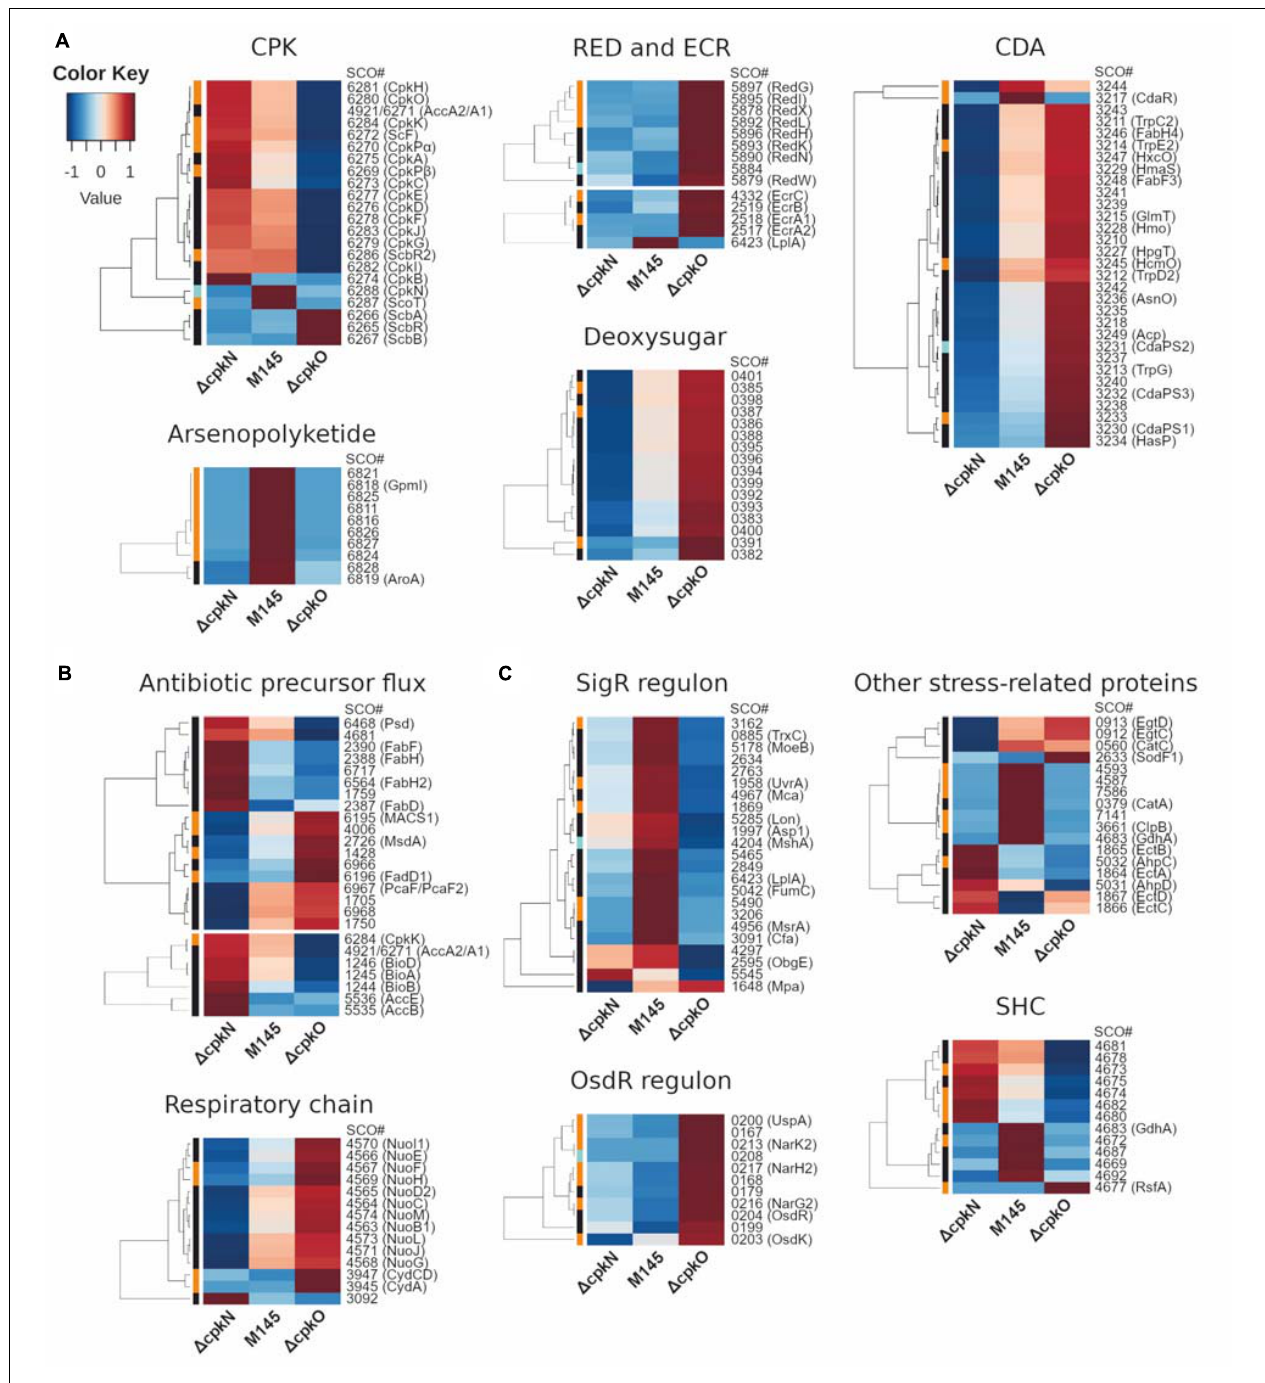
FIGURE 3 | Heatmap representation of mean abundances of proteins in S. coelicolor A3(2) M145, (cid:49) cpkO and (cid:49) cpkN strain. (A) Proteins from specialized metabolite biosynthetic clusters; ECR, expression correlated with RED. (B) Proteins associated with primary metabolism. (C) Proteins related to stress response and others; SHC, supercoiling-hypersensitive cluster. The method of quantification of each protein is indicated in colors on the left of the heatmap for extracted ion chromatogram (black), spectral count (orange) or peak count (cyan).